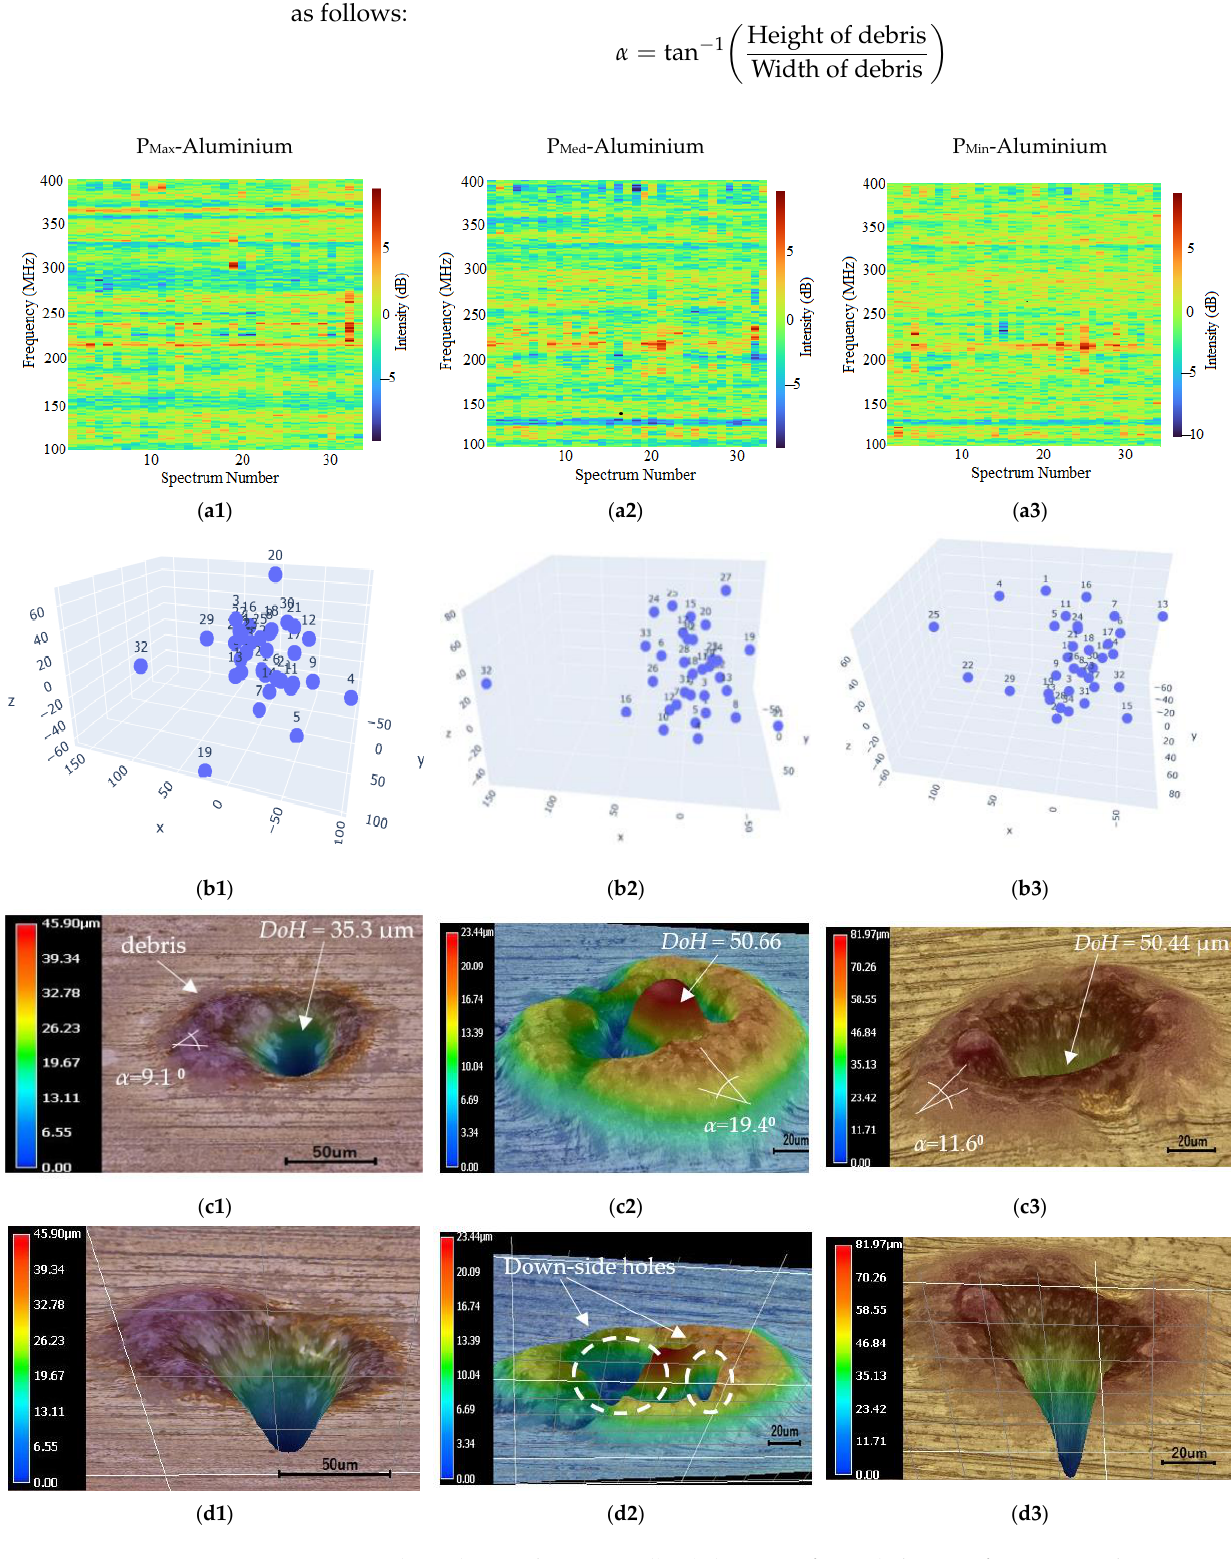
Figure 5. ( a1 – a3 ): RES heat map; ( b1 – b3 ): PCA of RES (where x: first principal component, y: second principal component and z: third principal components of PCA analysis); ( c1 – c3 ) : “Up - side” of Microscopic images; ( d1 – d3 ): “ Down- side “of Microscopic images. 1: Maximum laser Power, 2: Medium laser Power, and 3: Minimum laser Power to the Aluminum target.